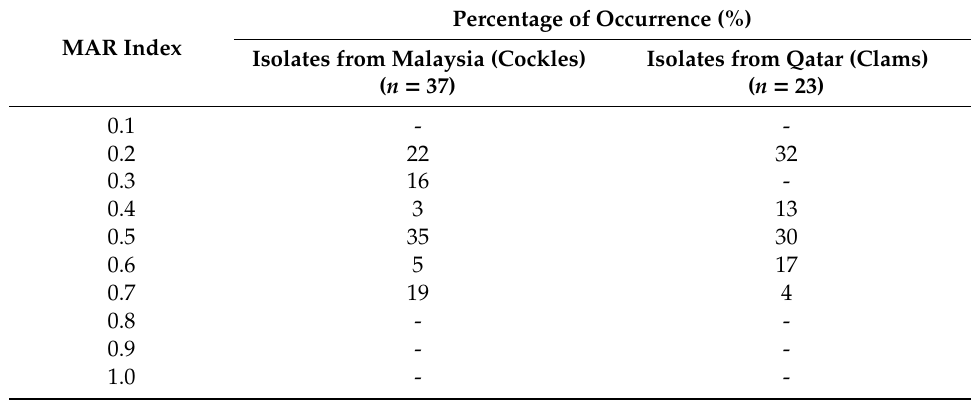
Table 3. Multiple antibiotic resistance (MAR) index of Vibrio vulnificus isolates ( n = 60) from Malaysia (cockles) and Qatar